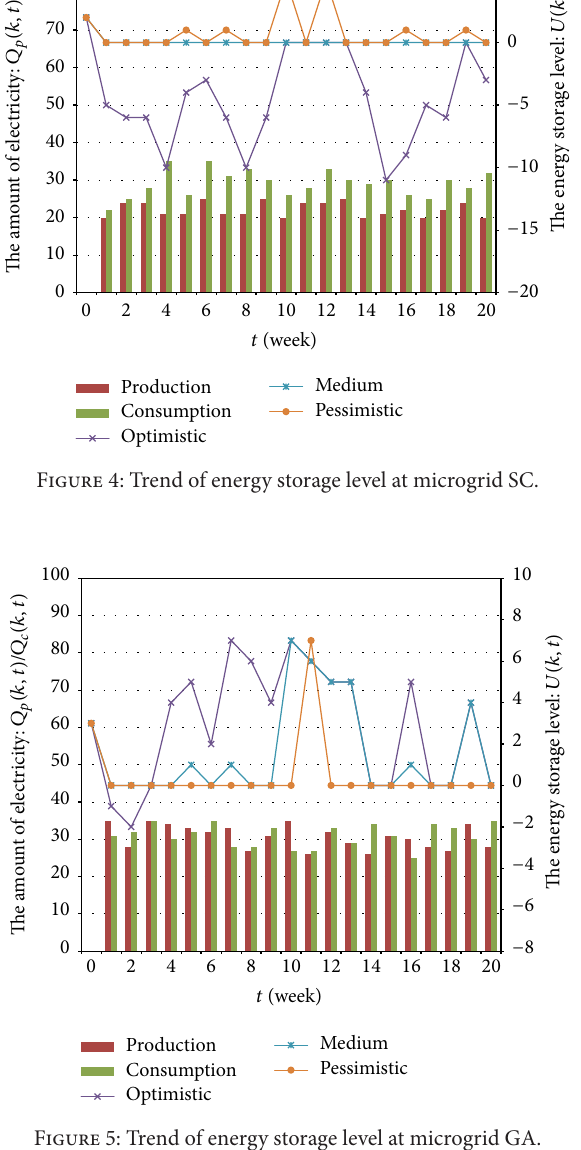
Figure 5: Trend of energy storage level at microgrid GA.